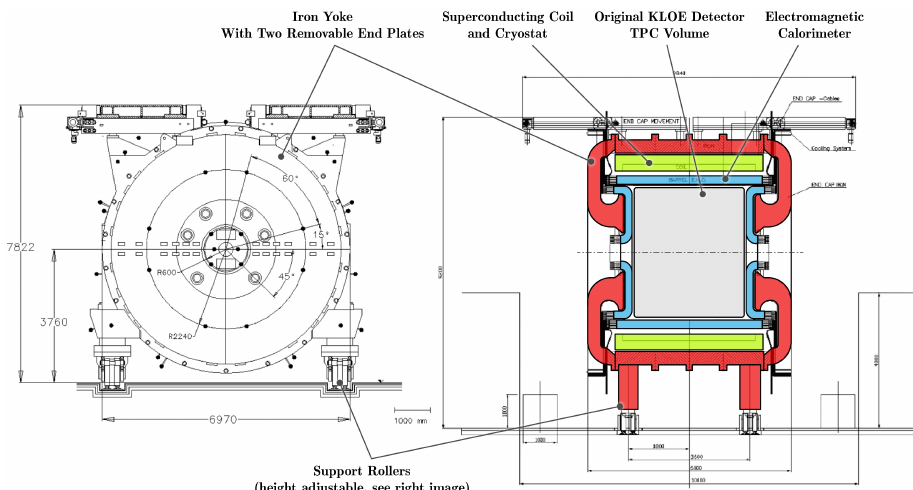
Figure 174. Schematic drawing of the primary SAND beam monitor components. The subdetector consists of a large superconducting coil surrounded by a thick iron yoke and end plates which produce a uniform magnetic field within the subdetector volume. The subdetector incorporates a lead-based electromagnetic calorimeter barrel. The detailed inner detector design is still ongoing and will be based on either 3DST, TPC, or straw tube